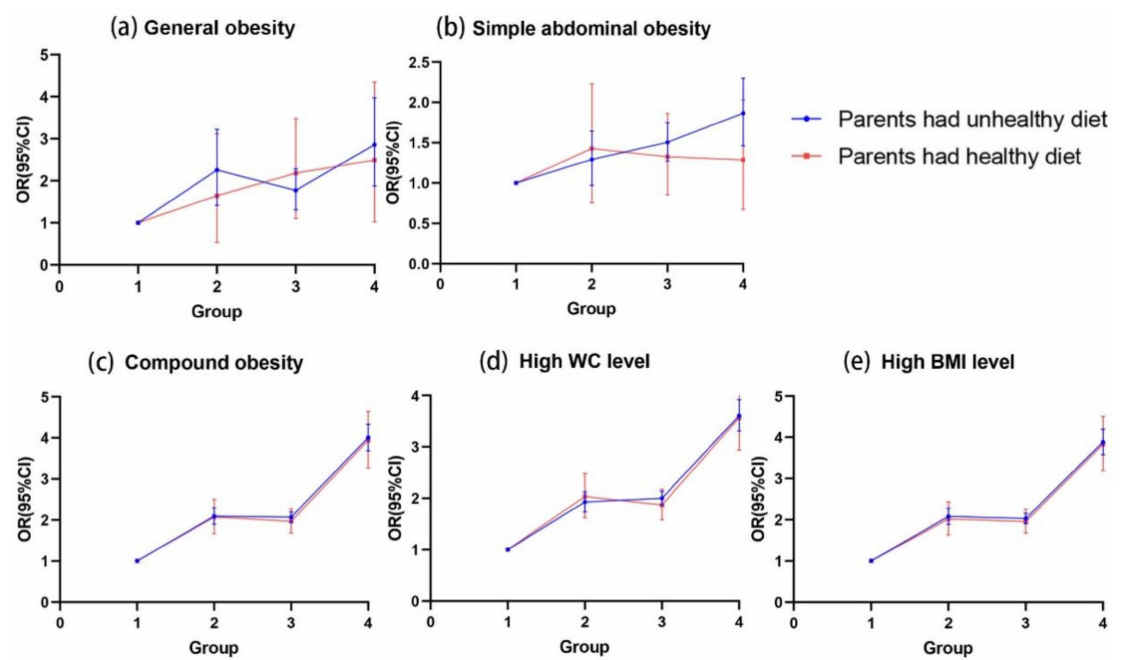
Figure 2. Association of OW/OB between parents and offspring, stratified by parental dietary behaviors. Notes: Adjust for offspring age, sex, resident area, single-child status, breastfeeding, SSBs consumption, meat consumption, breakfast eating, fast food consumption, and parental highest educational attainment. Group 1, offspring with no parental OW/OB; Group 2, offspring with only maternal OW/OB; Group 3, offspring with only paternal OW/OB; Group 4, offspring with both parental OW/OB.